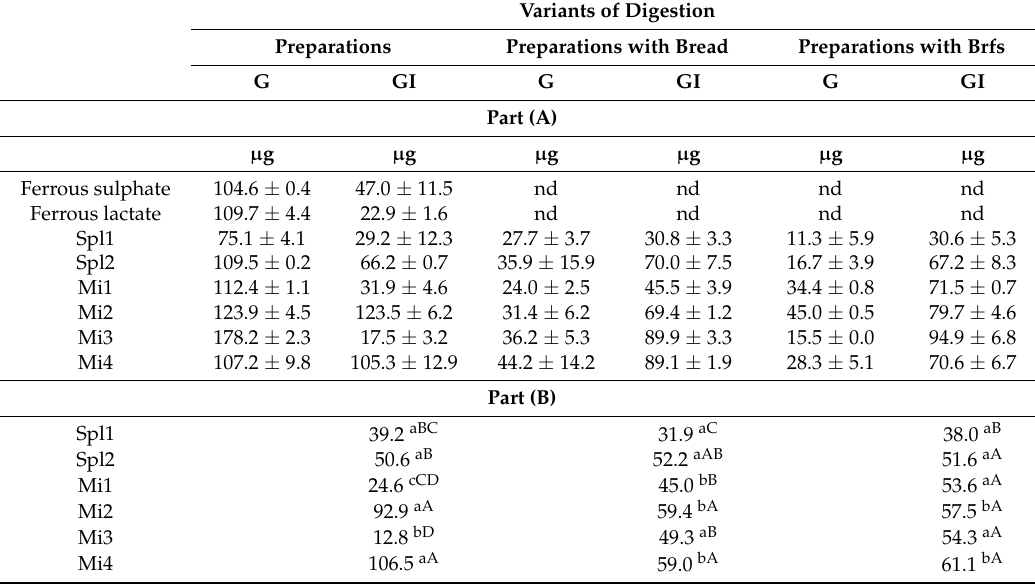
Table 3. Total iron content in the soluble fractions after gastric (G) and gastro-intestinal (GI) digestion (part A) and the bioaccessible fractions (BF %) (part B), from preparations (Spl1 and Spl2—dietary supplements; Mi1-Mi4 fortificants of encapsulated iron) digested individually or in the presence of a food matrix (white wheat bread or breakfast sandwich (Brfs)). Variants of Digestion Preparations Preparations with Bread Preparations with